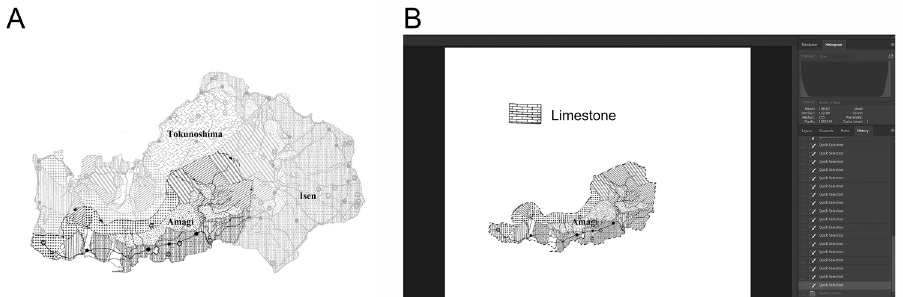
Figure 2. Image-based calculation of limestone bedrock occupancy (%) by municipality (representa- tive image: Amagi municipality, Tokunoshima). The calculation was performed as an evaluation of pixelation within an active area in a Photoshop session. ( A ) The municipality of interest was targeted for a deeper, color-intensity software setting to make it visually distinct from the rest of the island. ( B ) The municipality of interest was then isolated by cropping, and limestone bedrock occupancy was calculated as a percentage of pixels corresponding to limestone versus the total number of pix- els.